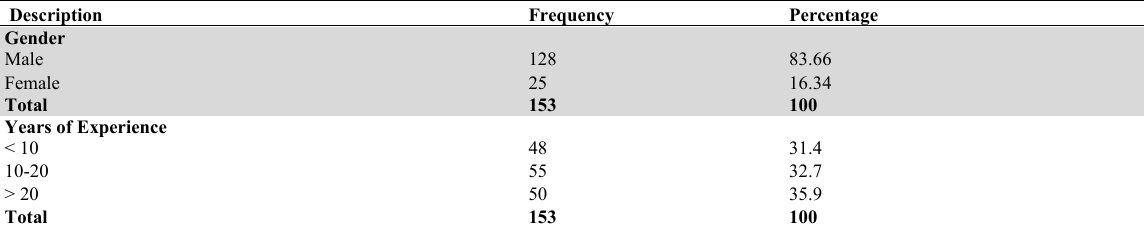
Demographic Profile